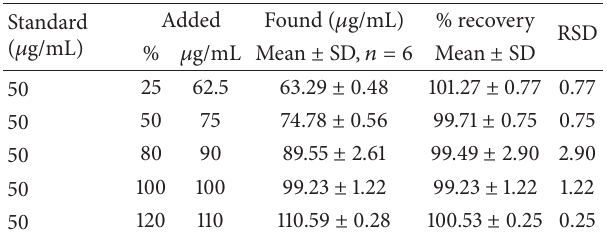
Table 5: Accuracy of the